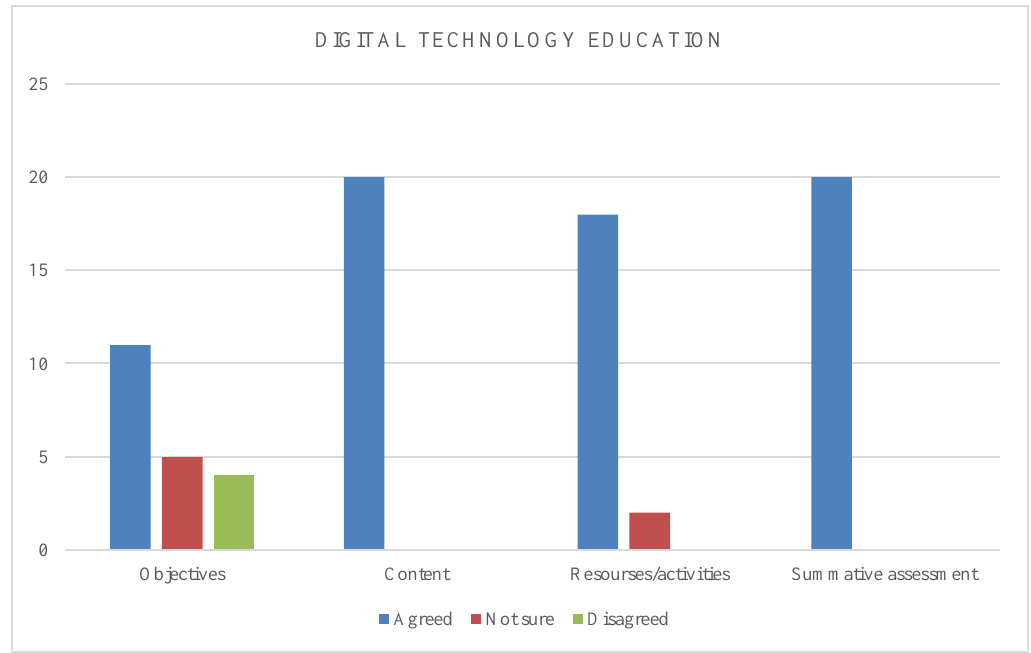
Figure 3: Digital technology